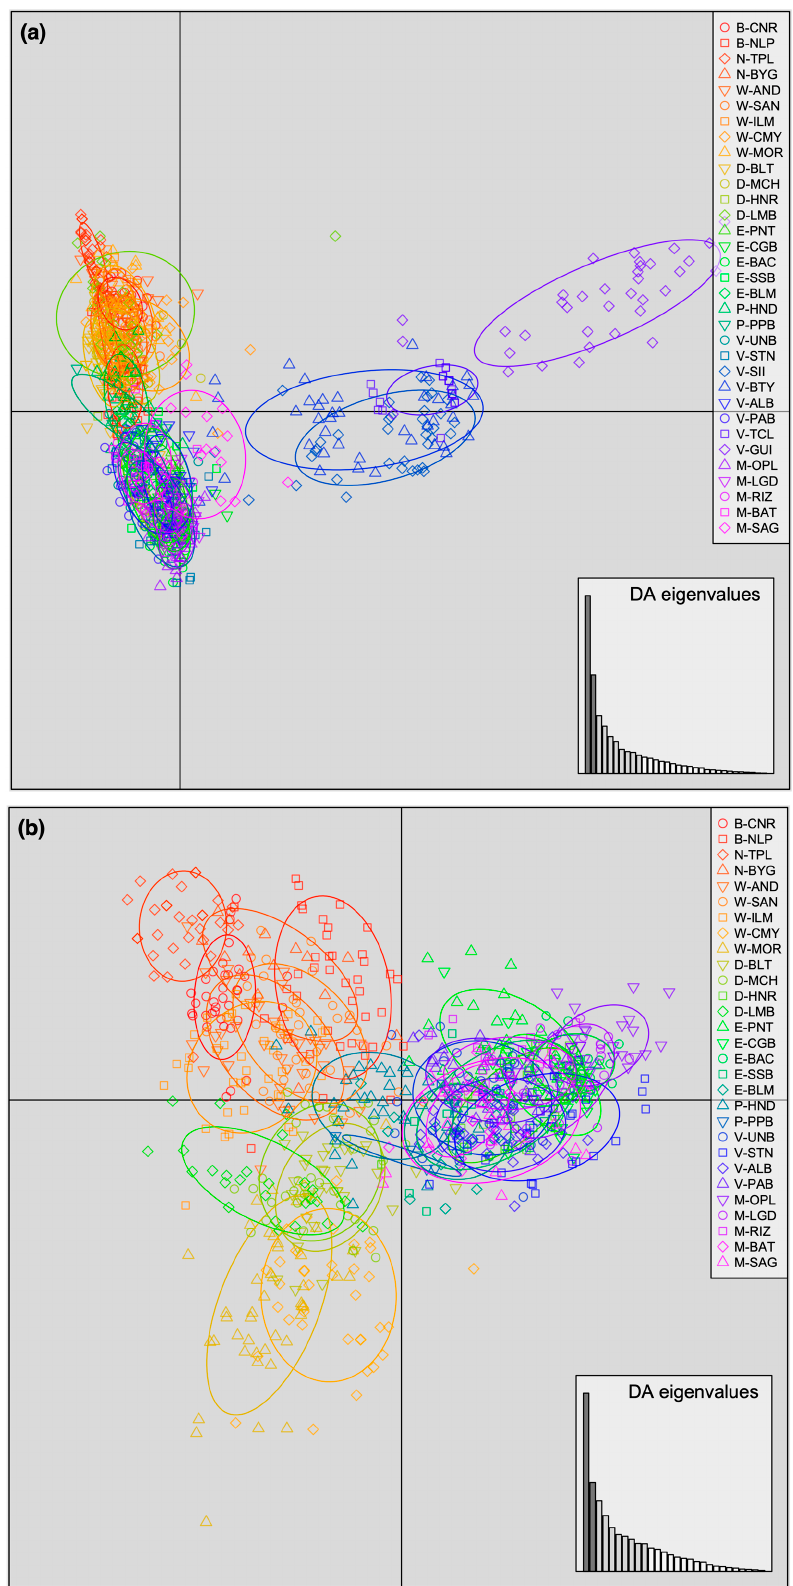
Figure 3. Map showing the frequency of Q-matrices from Bayesian clustering analysis implemented in STRUCTURE using clustering without prior information under the admixture model and assum- ing correlated allele frequencies. K values of these panels are K = 2 to K = 5.